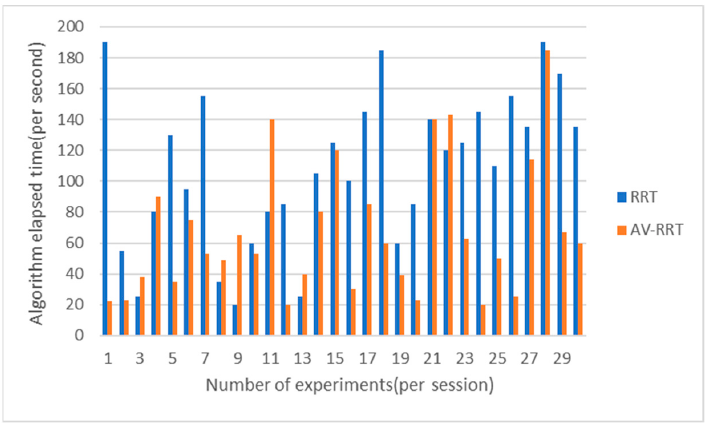
Figure 23. Comparison of consumption of time in the scene with moderate obstacles.